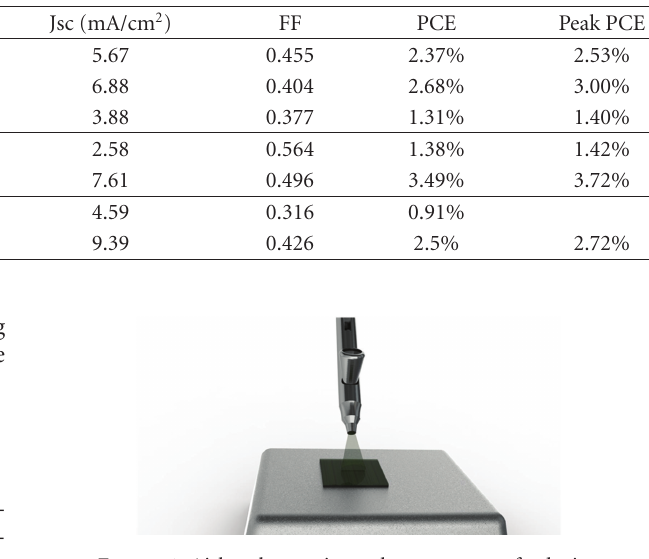
Figure 1: Airbrush spraying polymer on top of a